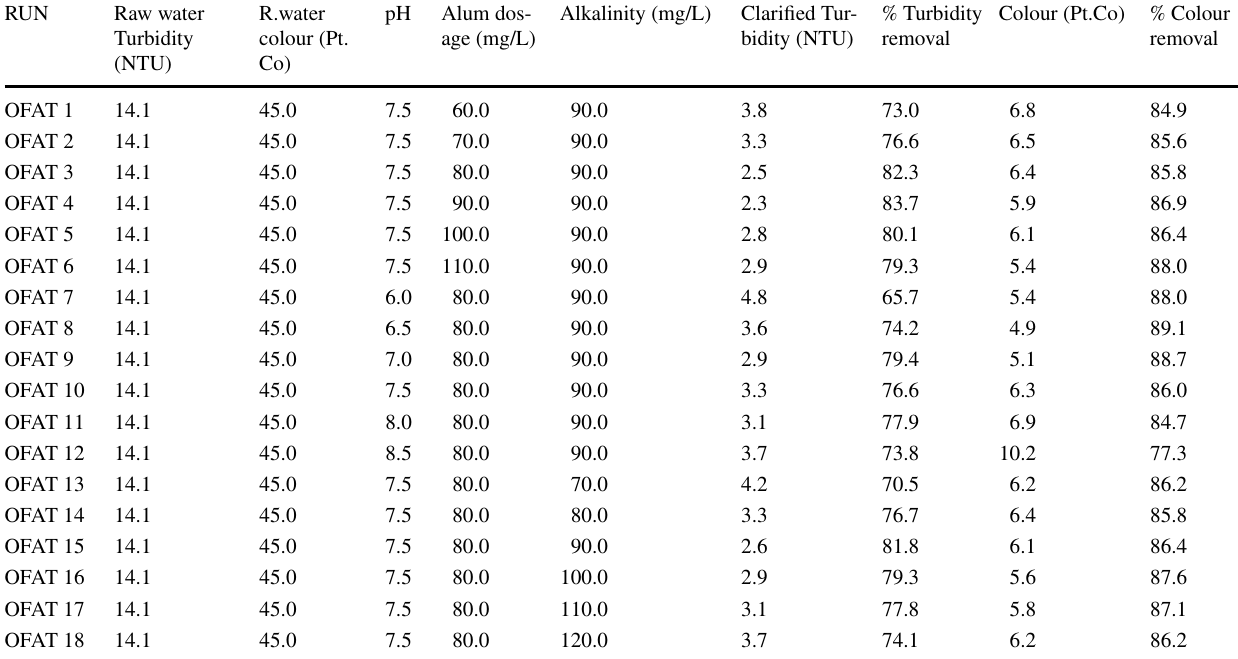
Table 1 One factor experimental jar test and response efficiency